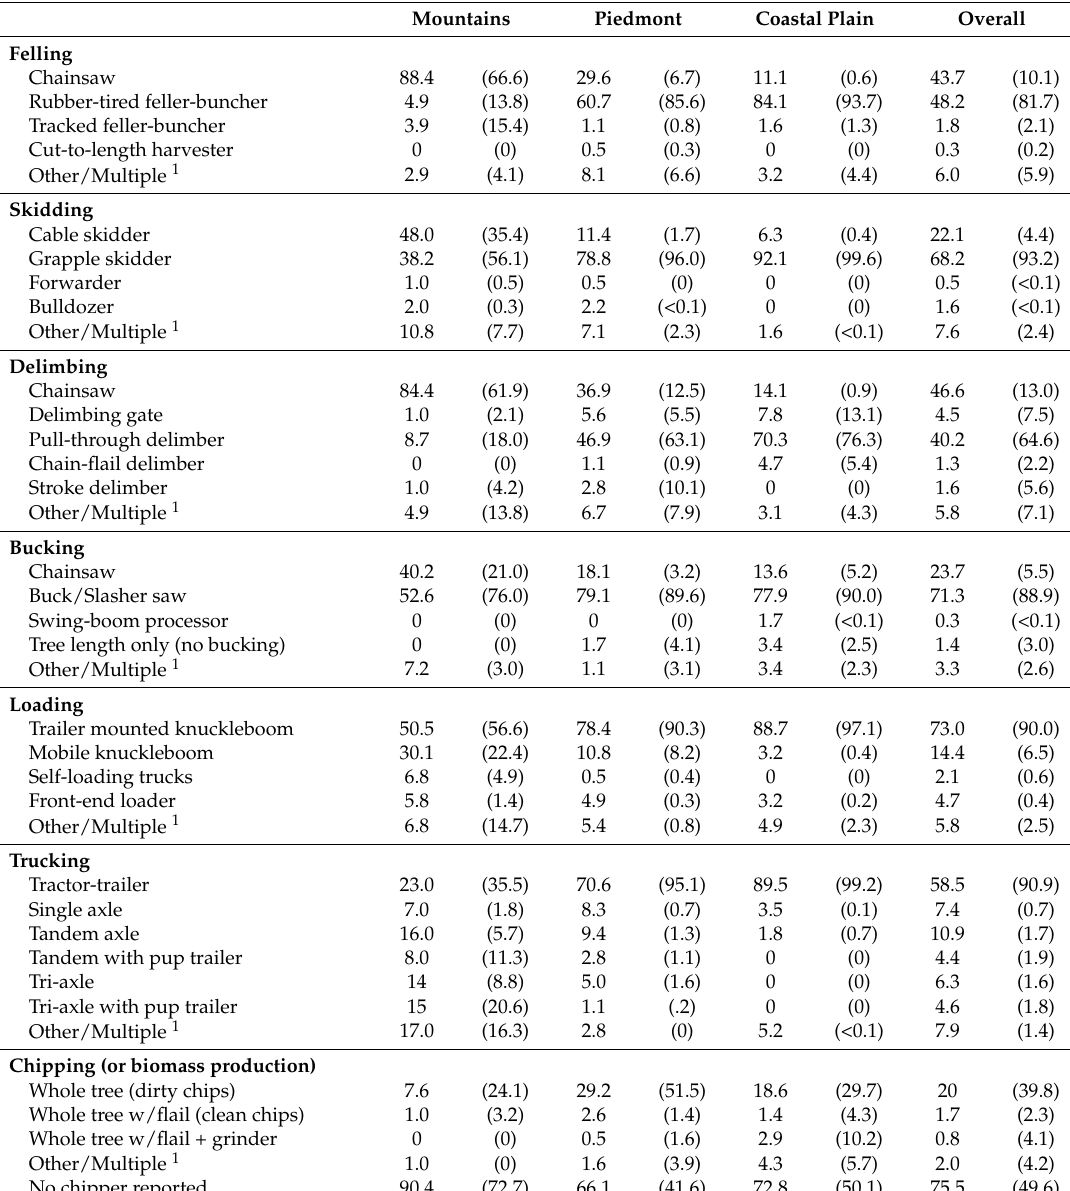
Table 4. Equipment used for each harvesting function. Percent of reported production represents the proportion of overall total reported production (tonnes) associated with businesses indicating they most commonly utilized that